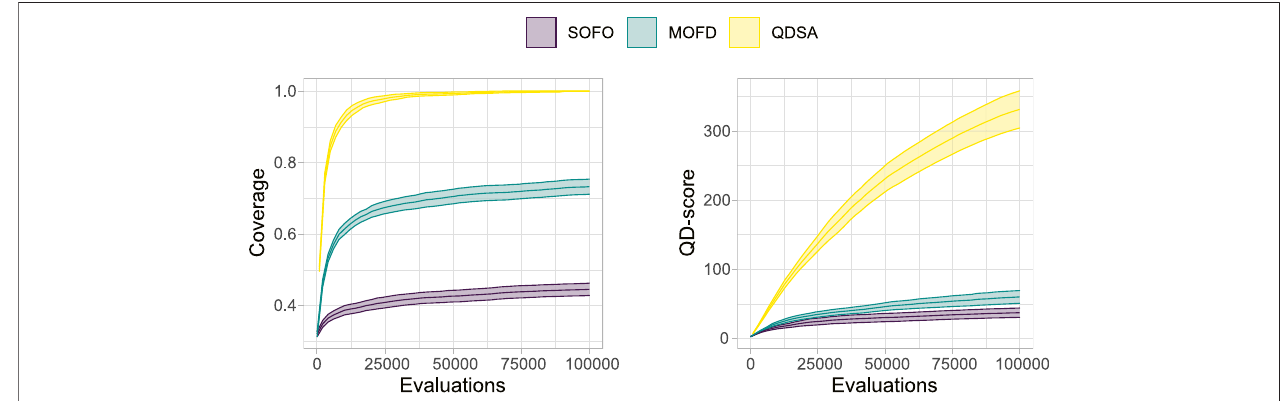
FIGURE6| QD-Metrics.Ontheleftthenormalizedcoverage(MouretandClune,2015),numberofdiscoveredmorphologicalniches,isshown.Coveragehasbeen normalized to the maximum number of niches found in any run for all three search algorithms. On the right the QD-score (Pugh et al., 2016), summation of fi tness for all solutions in the population, is shown. Both plots show the mean and a 95% con fi dence interval.